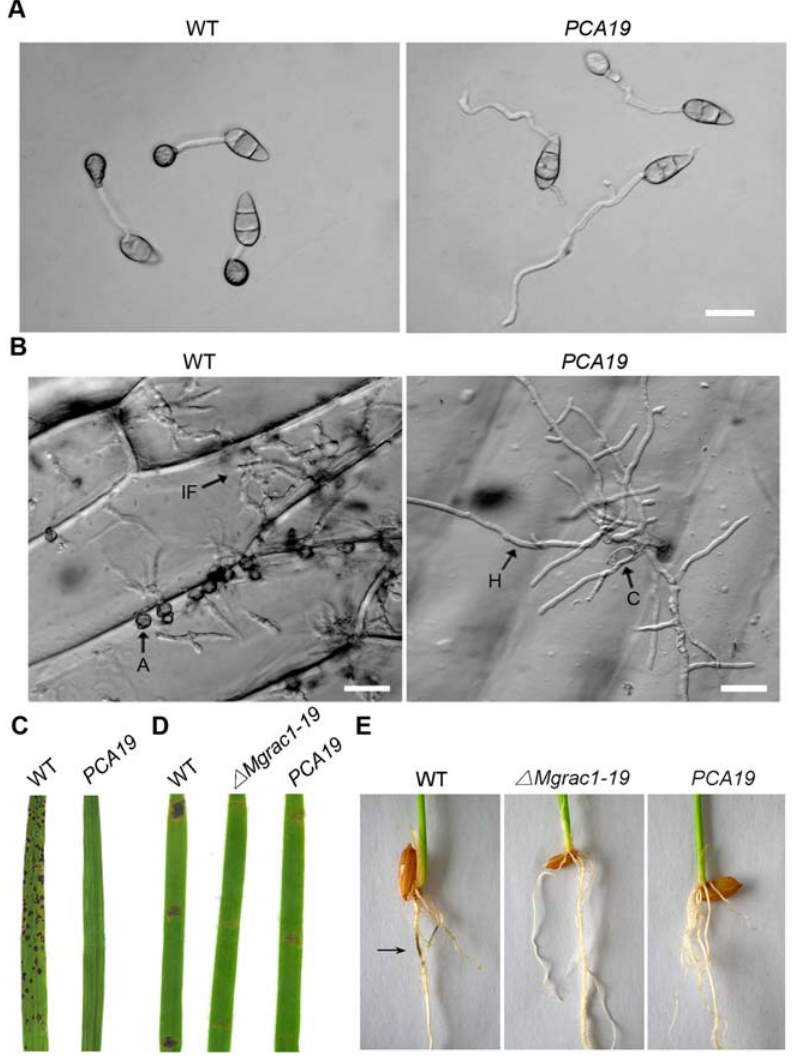
Figure 7. Chm1 D PBD rescues conidiation in Mgrac1 deletion mutants. (A) DIC microscopy of conidia of WT (70-15) and PCA19 (Chm1 D PBD expression in the Mgrac1 deletion mutant) collected after incubation the hydrophobic Gelbond film surface. Bar=20 m m. (B) Conidia suspensions (about 1,000 in 20 m l) of WT and PCA19 were inoculated on strips of onion epidermis. Infectious hyphae were examined at 1 day post-inoculation with DIC microscopy. A=appressorium, C=conidium, H=hypha, IF=infectious hypha. Bar=20 m m. (C) Leaves of rice cultivar CO39 were sprayed with conidial suspensions (1 6 10 5 conidia/ml) from WT and PCA19 . Typical leaves were photographed 7 days after inoculation. (D) Disease symptoms on the wounded leaf tissues of rice inoculated with mycelial plugs from WT, D Mgrac1-19 , and PCA19 . Typical leaves were photographed 5 days after inoculation. (E) Blast symptoms on rice roots. Arrow indicates necrotic lesions.